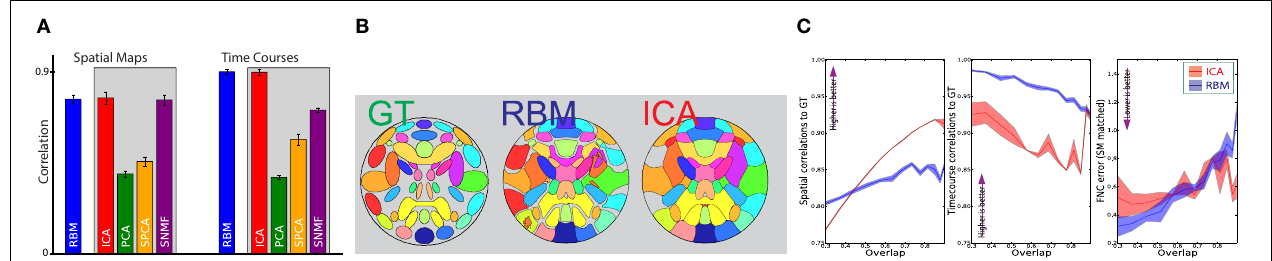
FIGURE 2 | Comparison of RBM estimation accuracy of features and their time courses with SMFs. (A) Average spatial map (SM) and time course (TC) correlations to ground truth for RBM and SMF models (gray box). (B) Ground truth (GT) SMs and estimates obtained by RBM and ICA (thresholded at 0 . 4 height). Colors are consistent across the methods. Gray